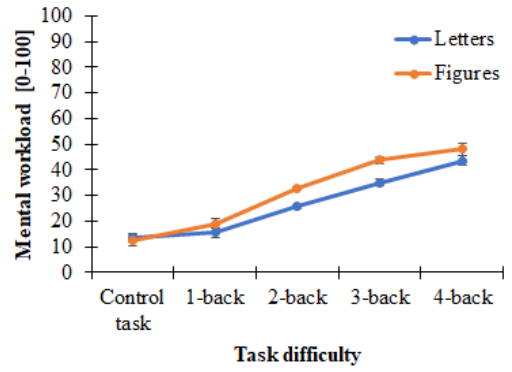
Figure 4. Means and standard errors for perceived workload as a function of task difficulty (mental load) and stimulus type (visual load). Data of the respective two levels of mental load (e.g. the two 1-back trials with letter stimuli) were